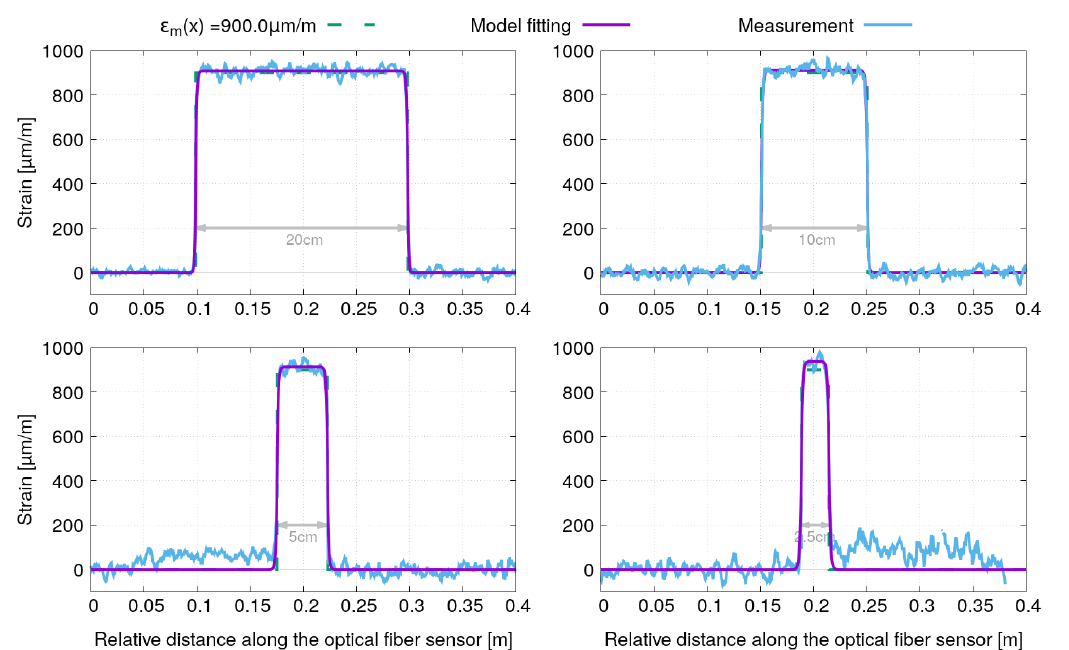
Figure 9. Fitting of the strain profiles obtained for the sample instrumented by optical fibers with polyimide coating under tensile test ( σ m = 180